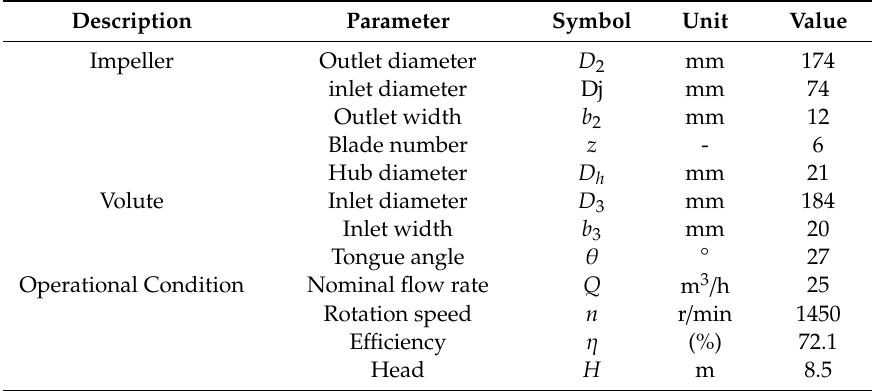
Table 1. Geometrical and operational parameters of the studied